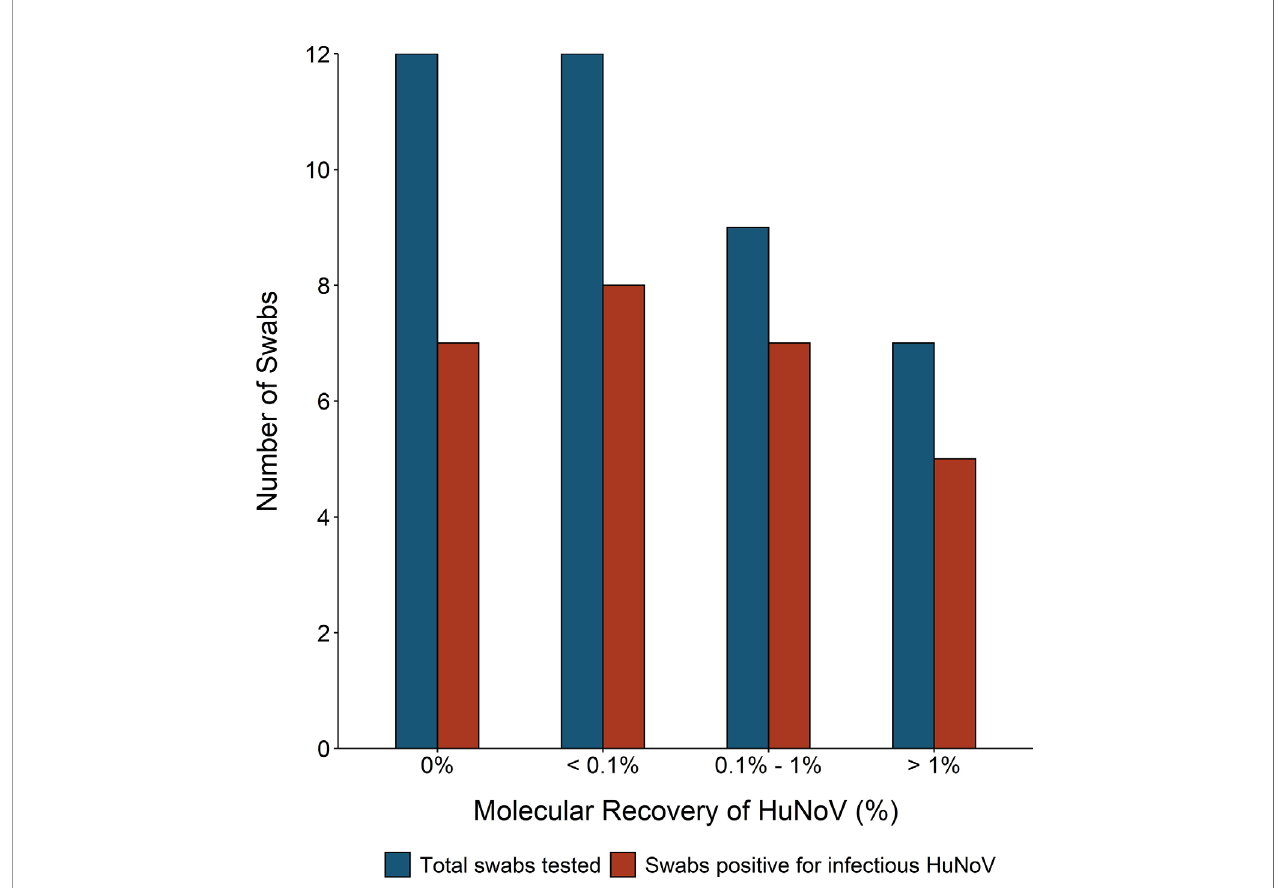
FIGURE 5 | Number of swabs tested and with detectable infectious human norovirus (HuNoV) compared to molecular percent recovery of HuNoV from experimentally inoculated fomites. One of three fomites — hospital bed tray (n = 19), door handle (n = 10), or sanitizer dispenser (n = 11) — were inoculated with 50 ml of HuNoV stool suspension containing 10 4 or greater HuNoV genome equivalents (GE) per 3 cm 2 . Fomites were swabbed with macrofoam swabs pre-moistened in phosphate buffered saline plus 0.02% Tween80. Human intestinal enteroid (HIE) monolayers were infected with swab eluate and were considered positive for infectious HuNoV if the fold increase in HuNoV GE between 1 and 72 h post infection (hpi) was greater than fi ve. Molecular percent recovery of HuNoV was calculated by comparing HuNoV GE added to fomite to HuNoV GE in recovered eluate, using